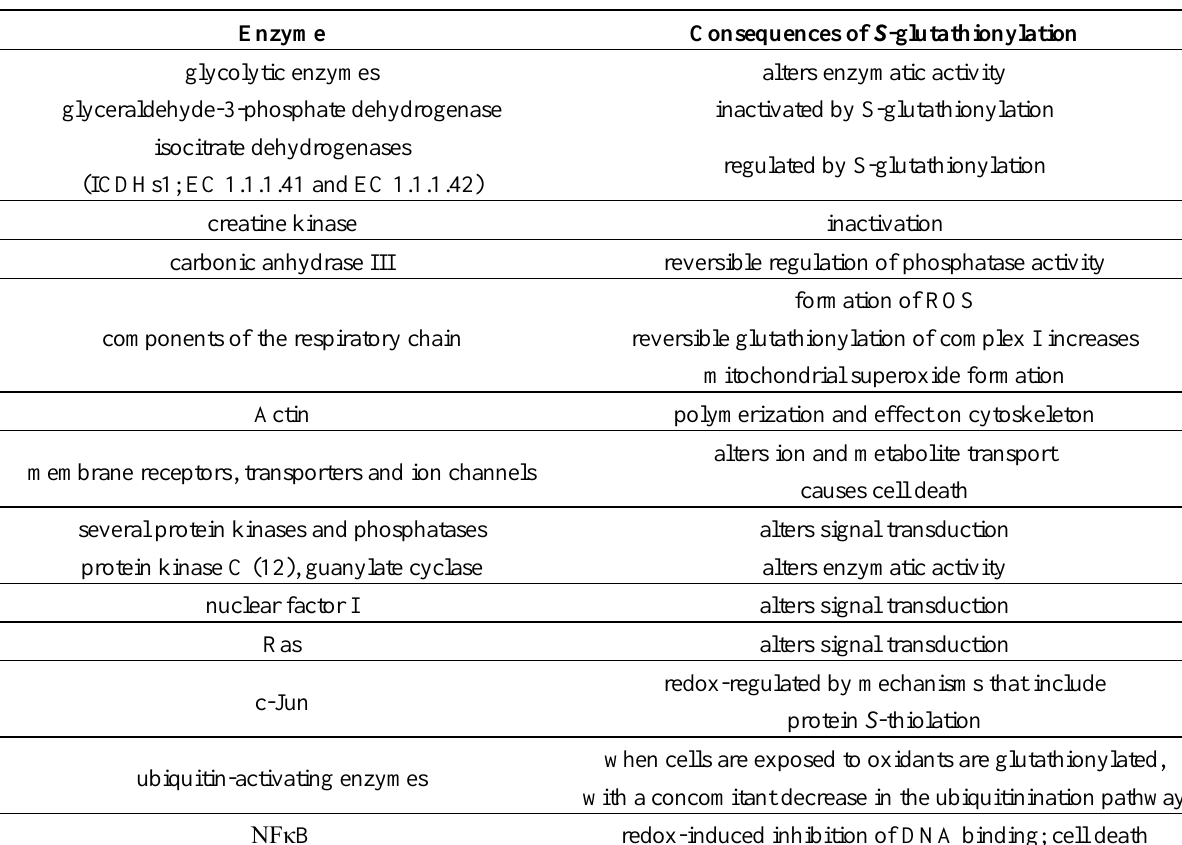
Table 1. A list of enzymes, receptors and regulatory proteins for which the literature